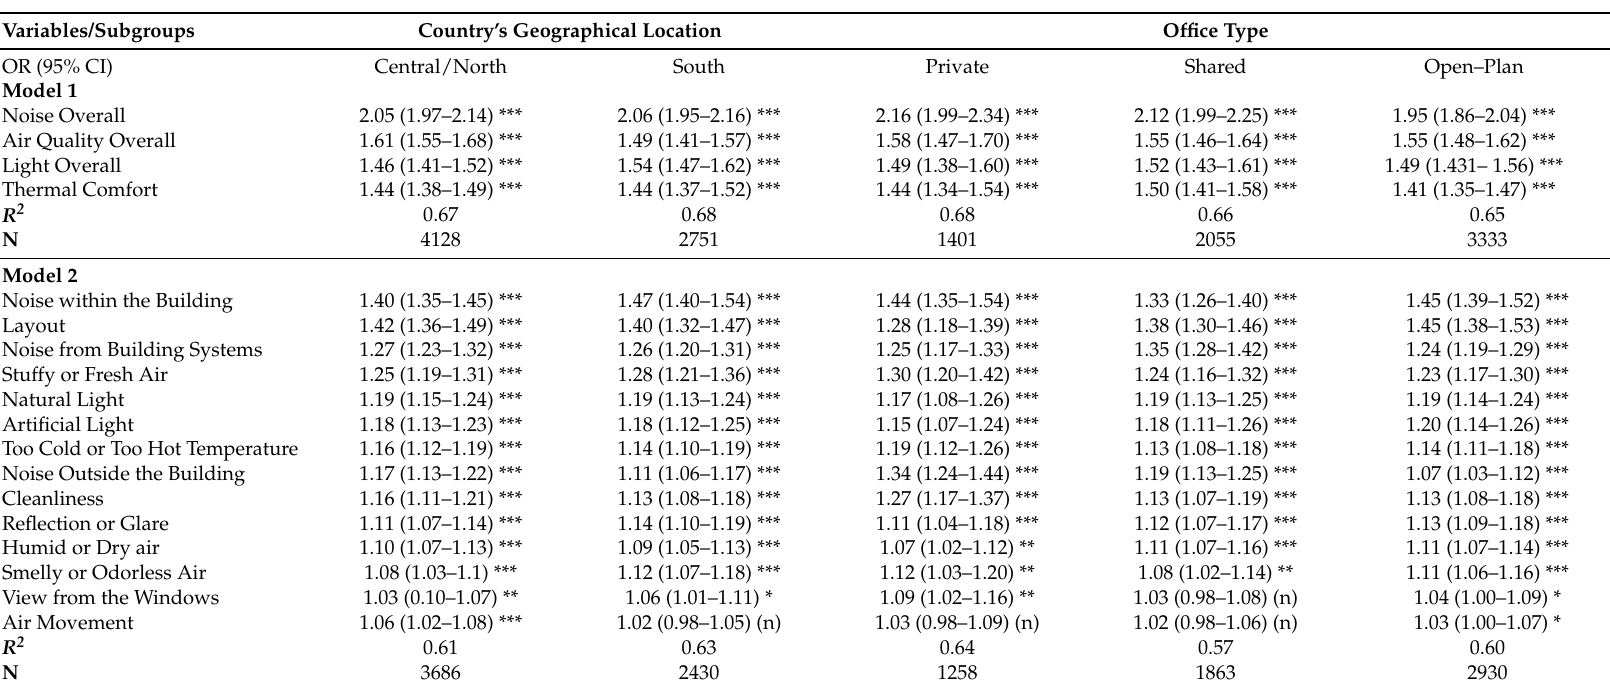
Table 6. Relations between overall comfort and satisfaction with indoor environmental quality (IEQ) (Model 1), and detailed indoor environmental parameters (Model 2) according to building characteristics in OFFICAIR